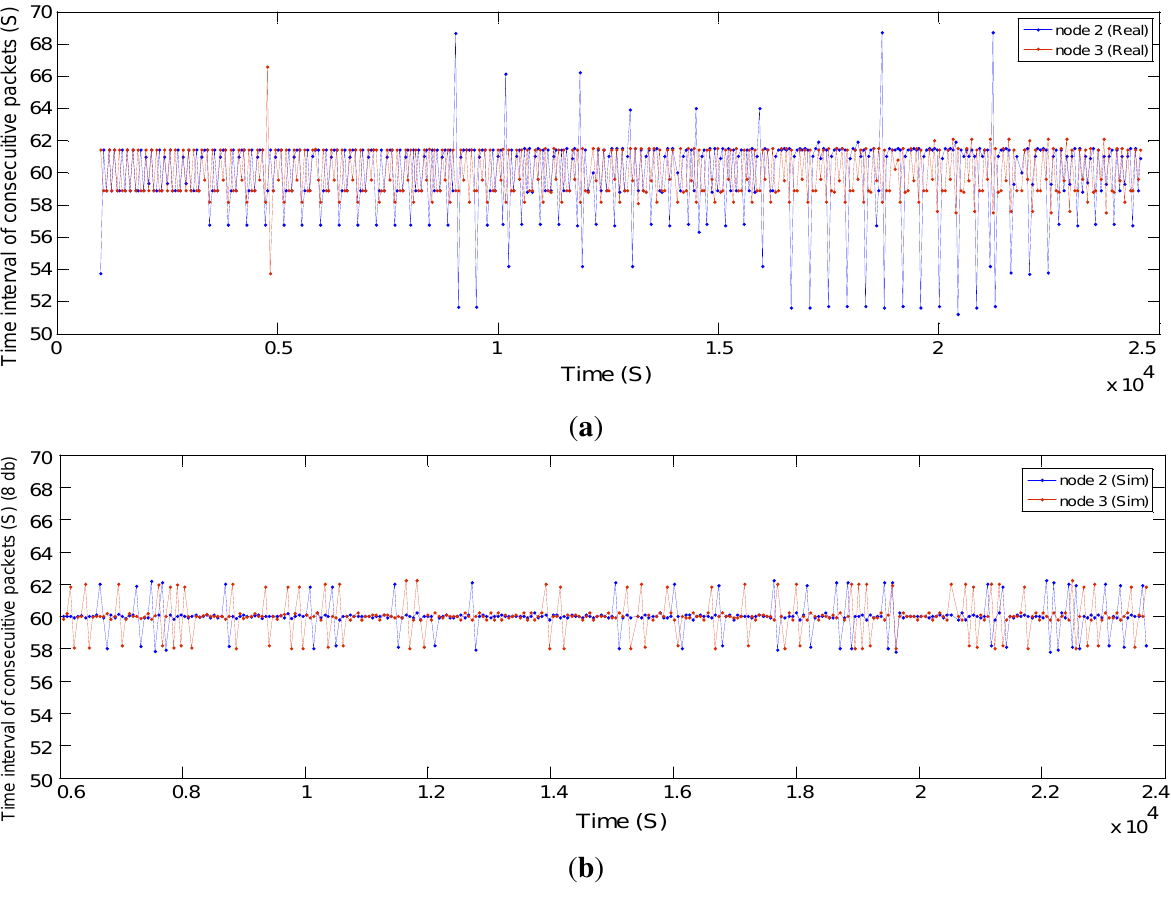
Figure 17. Time interval of the consecutive received packets for Nodes 2 and 3. ( a ) Real network; and ( b ) simulated network with a shadowing deviation of 8 dB.